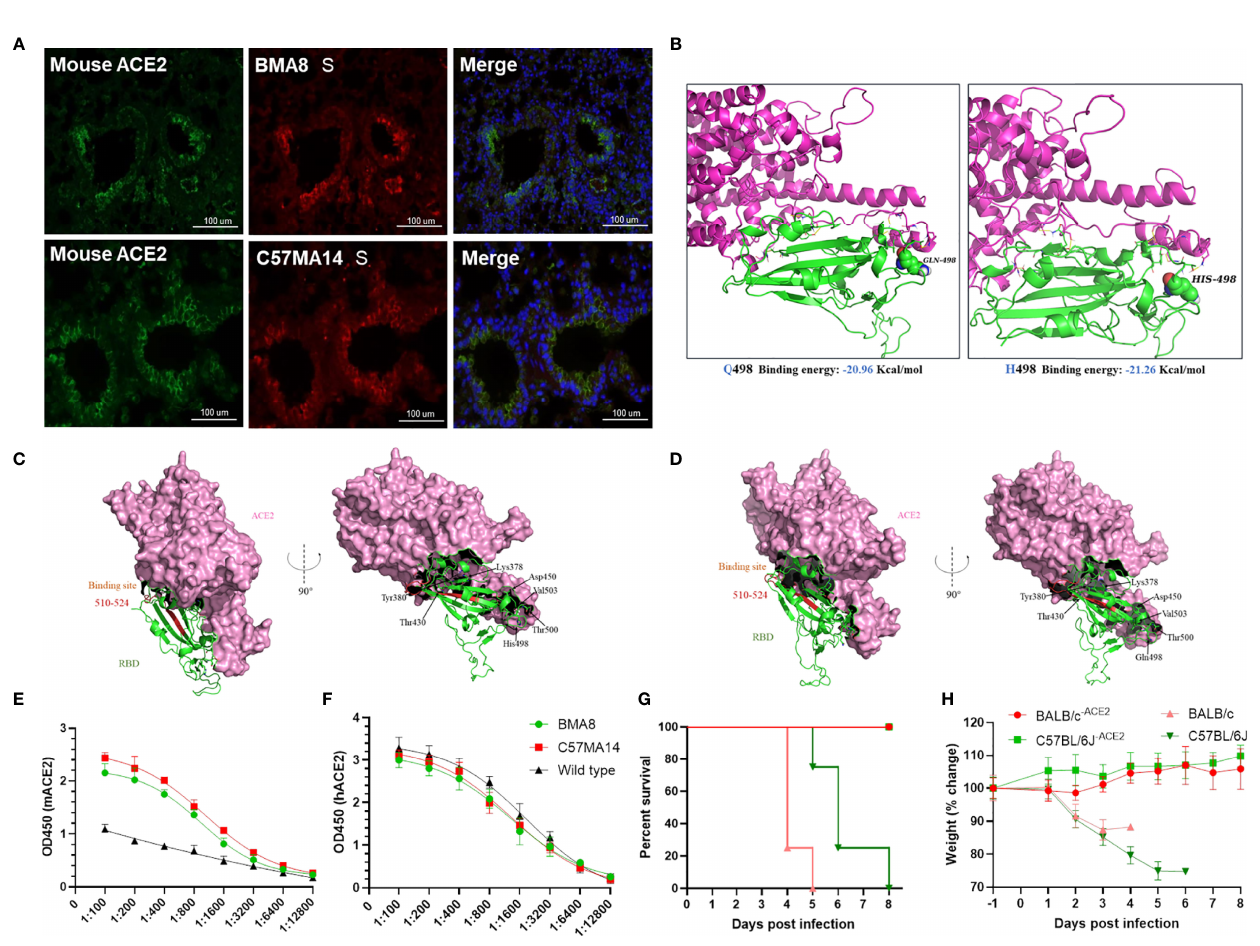
FIGURE 6 | Q498H substitution increased the binding af fi nity between receptor-binding domain (RBD) and murine angiotensin-converting enzyme 2 (mACE2). (A) Multiplex immuno fl uorescence staining of mouse lung section, severe acute respiratory syndrome 2 (SARS-CoV-2) (red), mACE2 (green), nuclei (blue). (B) Homology modeling of mouse ACE2 (purple) in complex with SARS-CoV-2 variant RBD (green) with Q498 (left) or H498 (right). (C, D) Contribution of each amino acid to the binding free energy in complex of RBD containing Q498 or H498 binding with mACE2. (E, F) ELISA for detecting the binding ability between SARS-CoV- 2 RBD and ACE2. (G, H) Survival rate and weight change of BALB/c -ACE2 mice (n = 3) and C57BL/6J -ACE2 mice (n = 3), while normal BALB/c mice (n = 4) and C57BL/6J mice (n = 4) were as